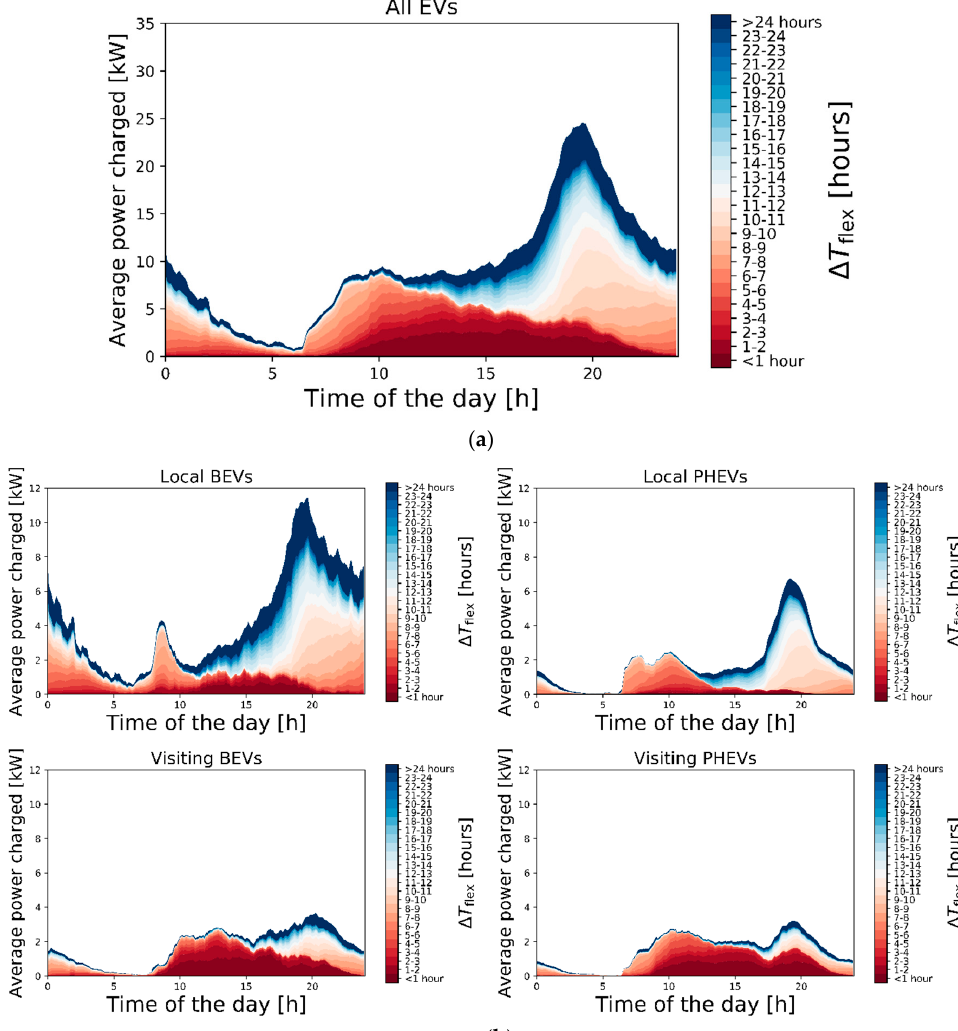
Figure 6. ( a ) Available flexibility of aggregated EV demand in measured data, average values for each time of the day (5 min resolution). The demand profile shows a peak in the evening that is highly flexible, while the flexibility of the EV demand during the day is limited. ( b ) Aggregated demand profiles and available flexibility per EV category in measured data; average values for each time of the day (5 min resolution).